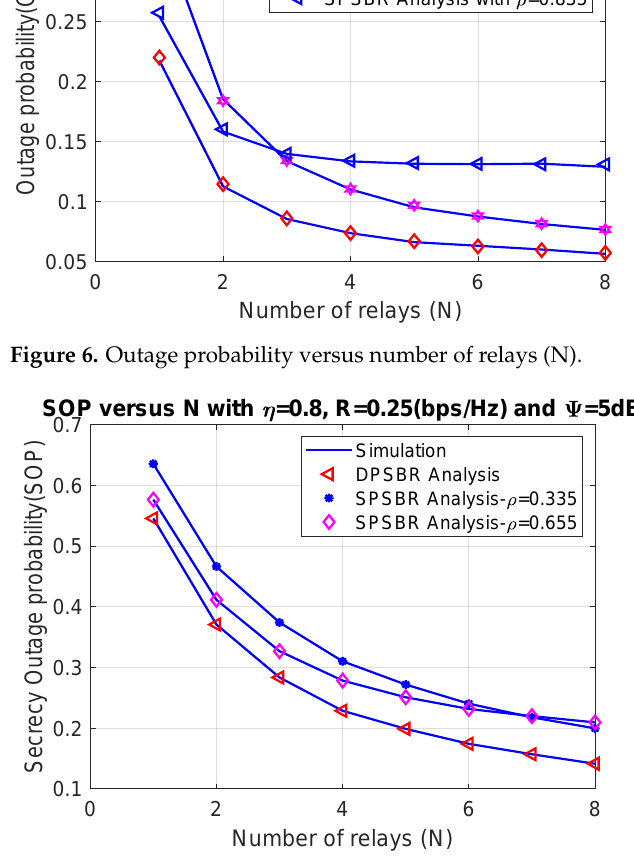
Figure 7. Secrecy outage probability versus number of relays